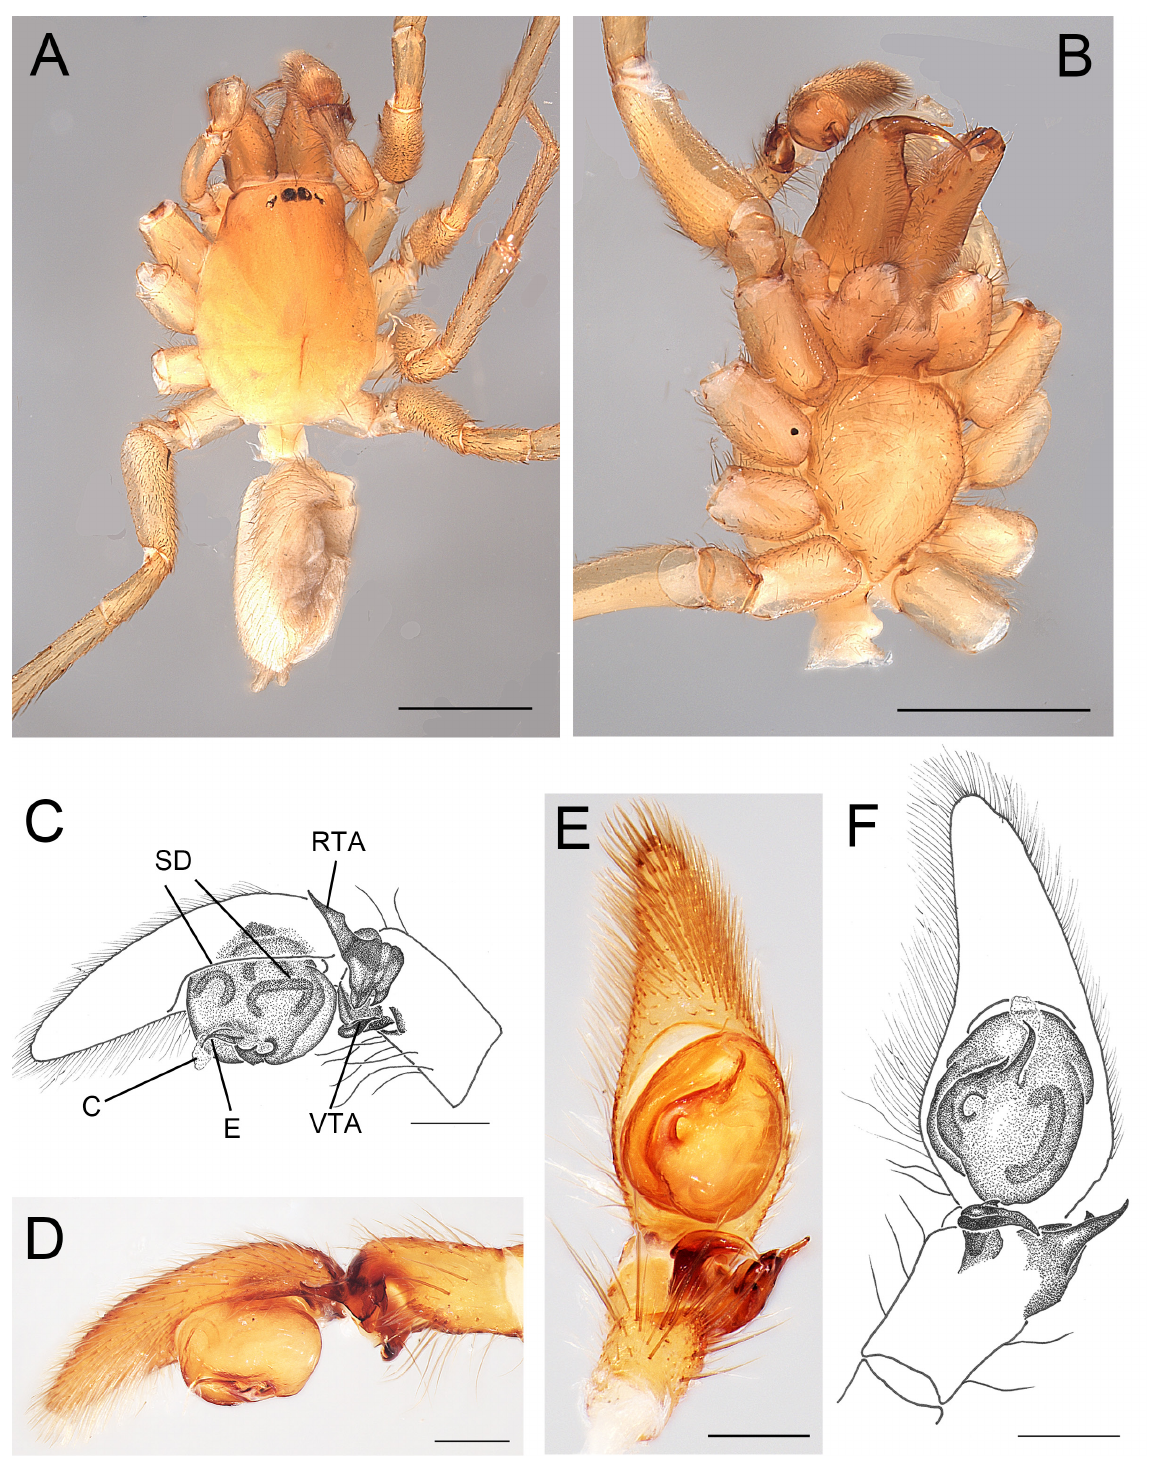
Fig. 17. Andromma deogratias sp. nov., ♂, holotype (BE_RMCA_ARA.Ara 246049). A . Habitus, dorsal view. B . Cephalothorax, ventral view. C–D . ♂, left palp, retrolateral view. E–F . Same, ventral view. Abbreviations: C = conductor; E = embolus; RTA = retrolateral tibial apophysis; SD = sperm duct; VTA = ventral tibial apophysis. Scale bars: A = 0.5 mm; B = 1 mm; C–F =